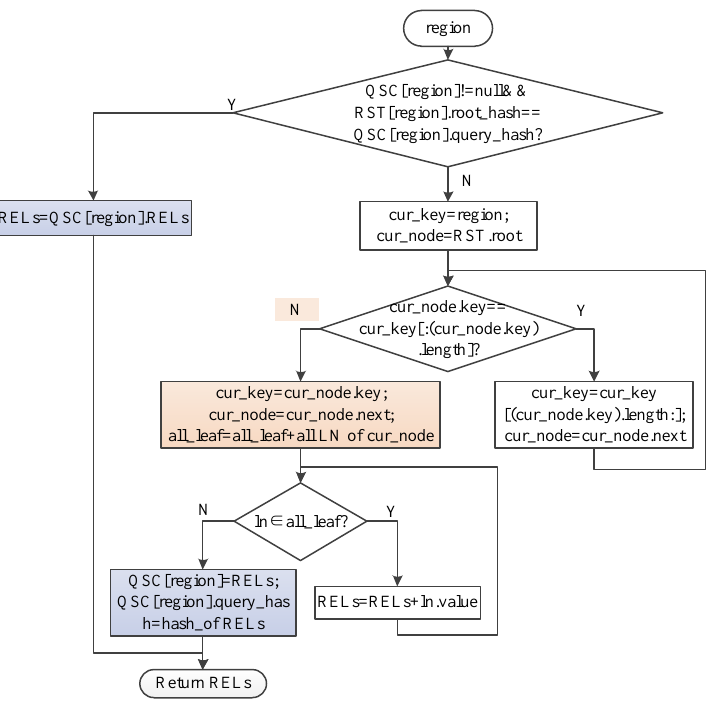
Figure 4. Flow chart for prefix query of